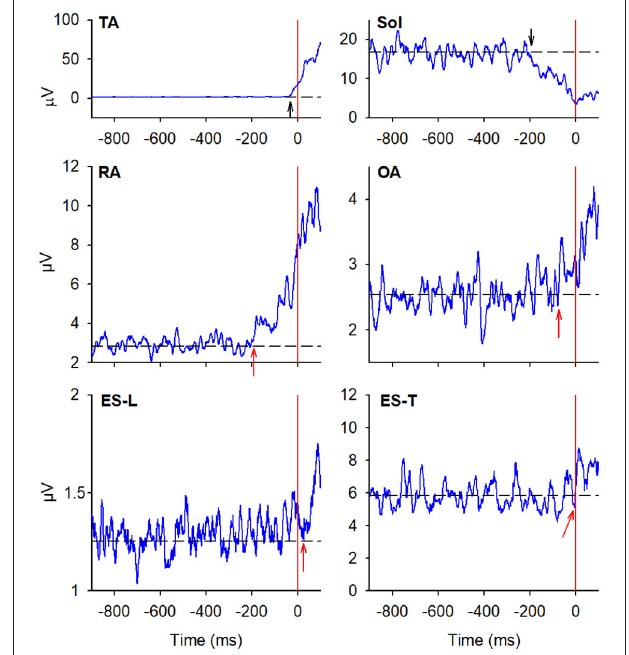
FIGURE 3 | EMG activity in the prime mover (TA and Sol) and trunk postural muscles (RA, OA, ES-L, and ES-T) recorded on the trailing side (left) of the same representative subject as in Figure 2 . Vertical red lines at time 0 mark the onset of the backward CoP shift. Arrows in each EMG plot mark the onset of excitation (upward arrow) or inhibition (downward arrow). Black dashed lines represent the average muscle activity in the baseline time